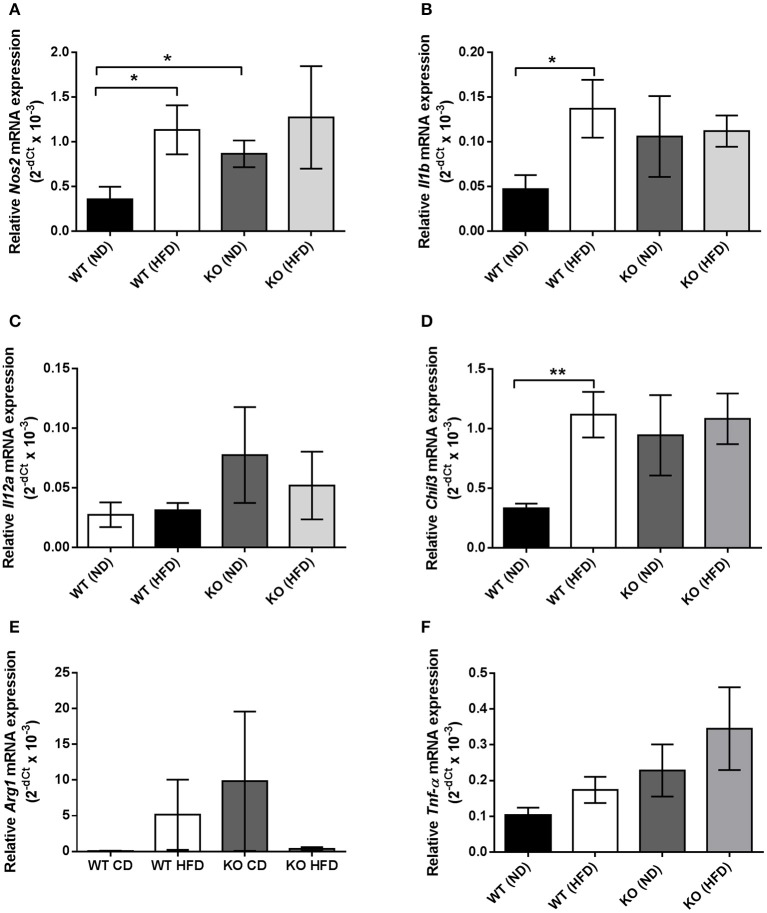
Quantification of macrophage marker expression within thoracic PVAT samples using RT-PCR. (A,B), HFD significantly raised mRNA expression of M1 markers Nos2 and Il1b, encoding iNOS and IL-1β in WT PVAT but had no effect in PVAT from AMPK α1 KO mice. KO PVAT had a higher expression of iNOS compared to WT PVAT in mice fed ND. (C) Expression of Il12a, encoding IL-12 was unchanged following HFD in either WT or KO mice. (D) HFD also significantly increased expression of the M2 marker Chil3, encoding YM1 in WT but not KO mice. (E) Expression of the M2 marker Arg1, encoding arginase was unchanged following HFD in either WT or KO mice. Similarly, expression of Tnf-α, encoding TNF-α was unchanged following HFD in either WT or KO mice (F). Values are expressed as means ± SEM, n = 4 for all groups; *p < 0.05 and **p < 0.01 vs. WT (ND). iNOS- inducible nitric oxide synthase; IL-1β- interleukin 1β; YM1, Beta-N-acetylhexosaminidase.